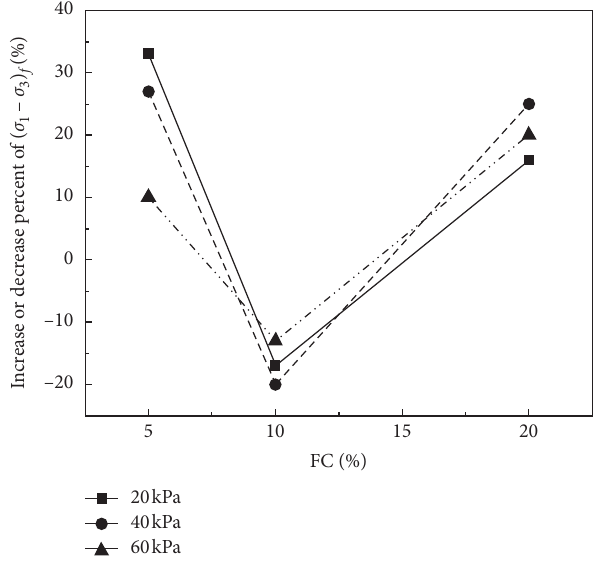
Figure 16: Increase or decrease percent of ( σ samples against FC after